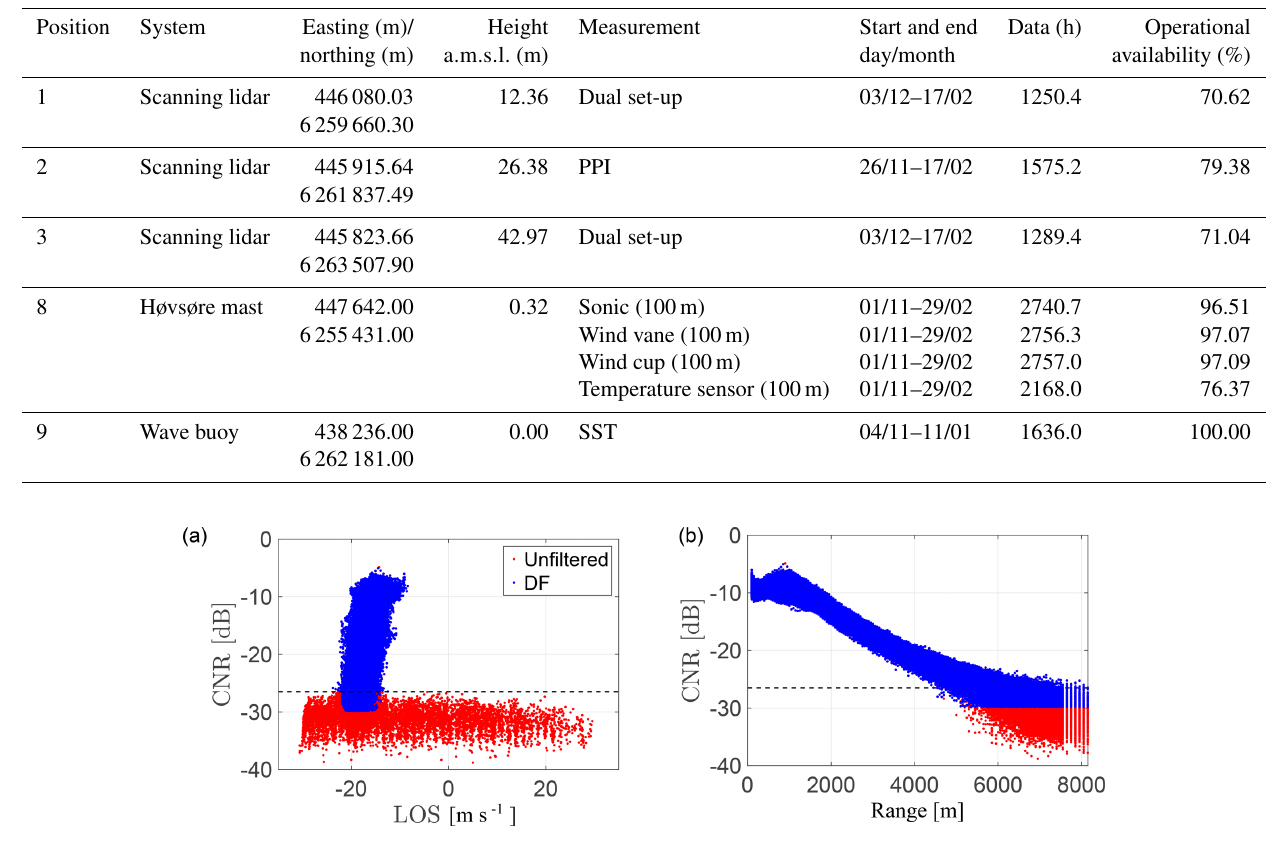
Figure 3. LOS–CNR plot (a) and range–CNR plot (b) for the original lidar data (red and blue colours) and the data filtered with the dynamic filter (DF) (blue) for a 10min measurement period. The dashed line represents the threshold line of − 26.5dB used in the conventional